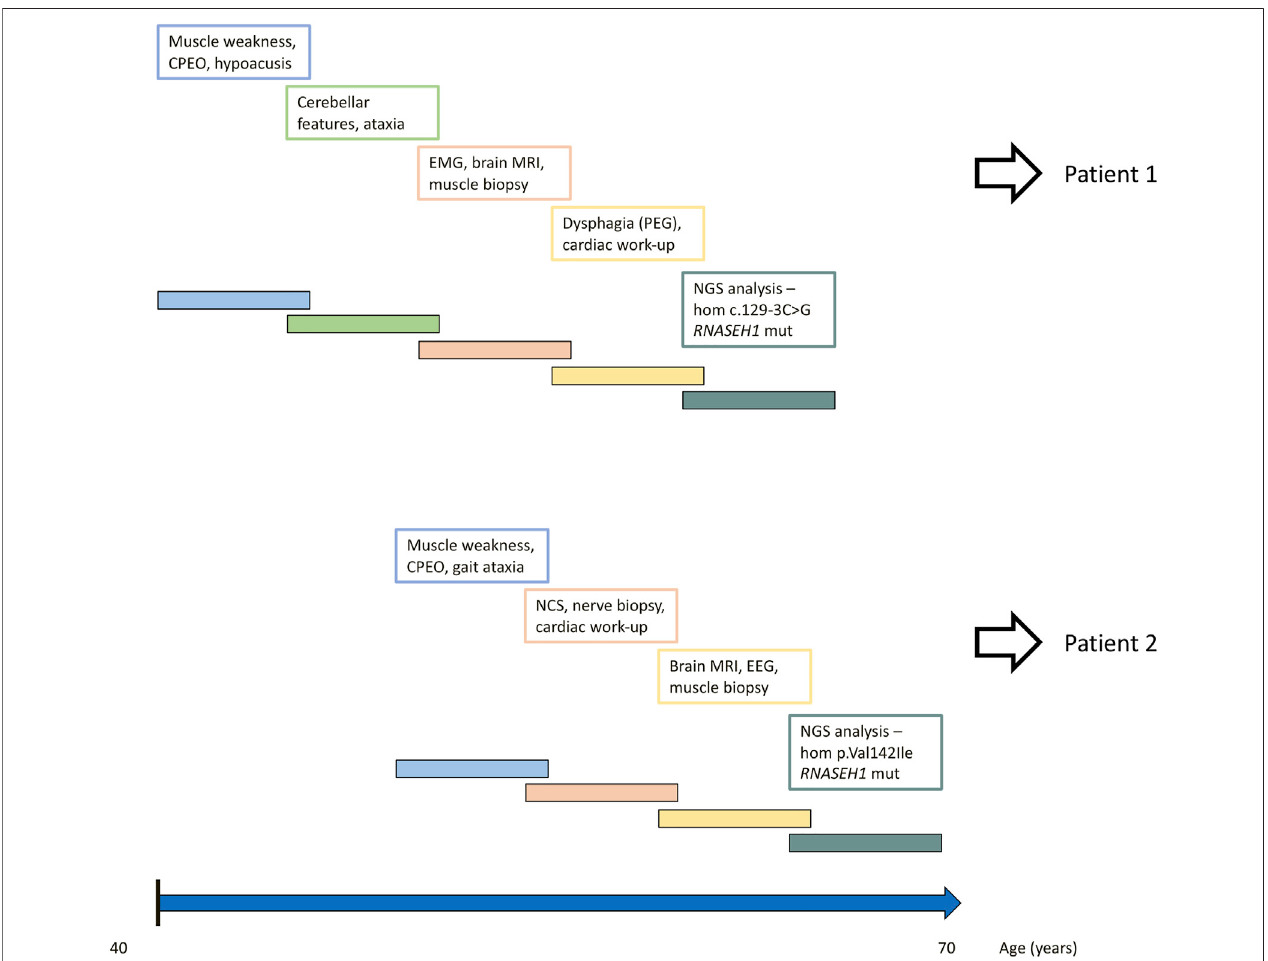
FIGURE 2 | Timeline of relevant clinical signs and symptoms and of diagnostic testing performed during disease progression of both